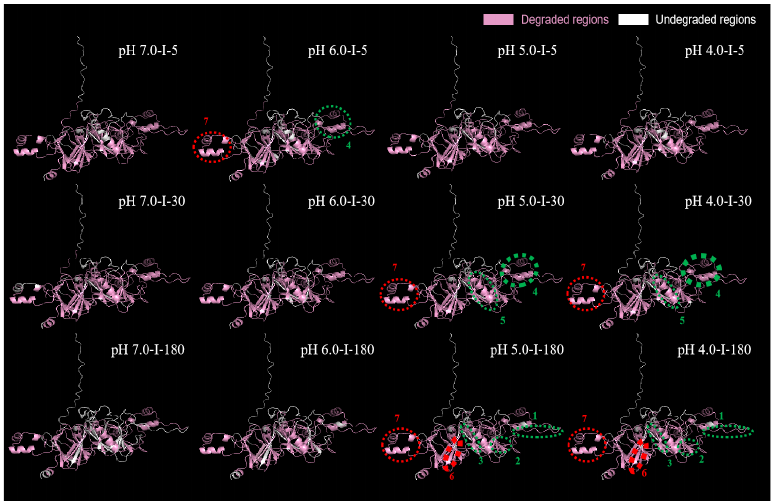
Figure 8. Distribution of gastrointestinal digestion sequence in the regions of glycinin G2 in the FSPI digestates. I-5, I-30, and I-180 represent the gastrointestinal digestates collected from the artificial intestine at 5 min, 30 min, and 180 min, respectively.